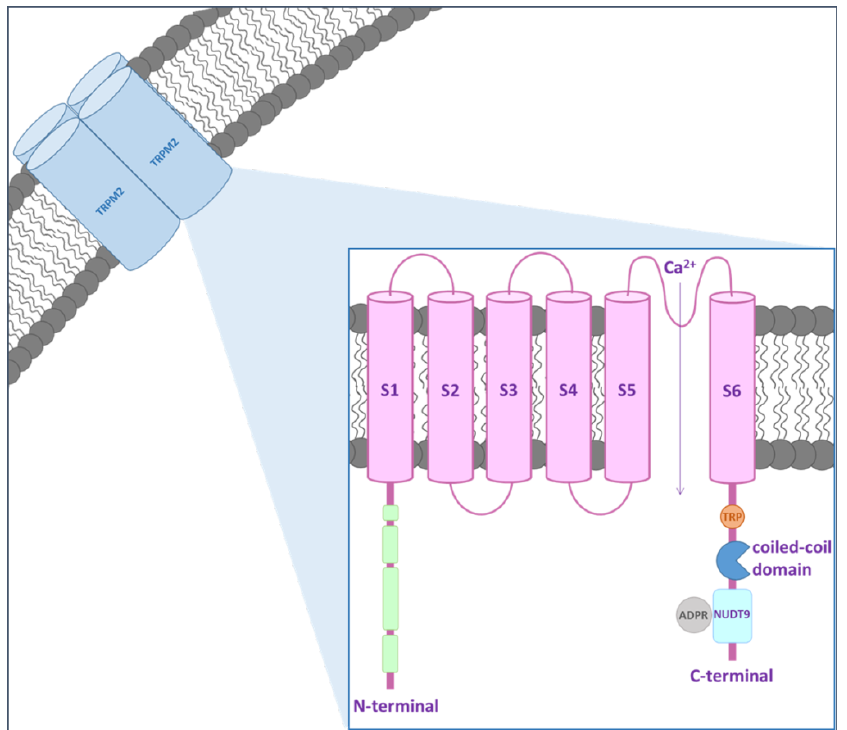
Figure 1. TRPM2 protein structure. TRPM2 channel includes 6 transmembrane domains, with a re-entry loop that forms a pore located between domains 5 and 6. Regulatory regions of the channel are contained within the cytoplasmic N- and C-termini.